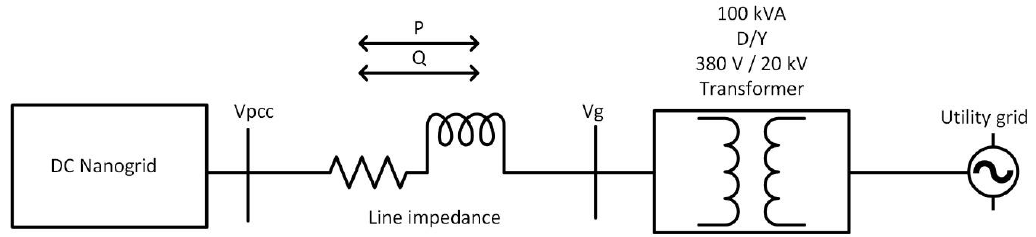
Figure 9. The DC nanogrid connected to an AC bus of the AC distribution grid.